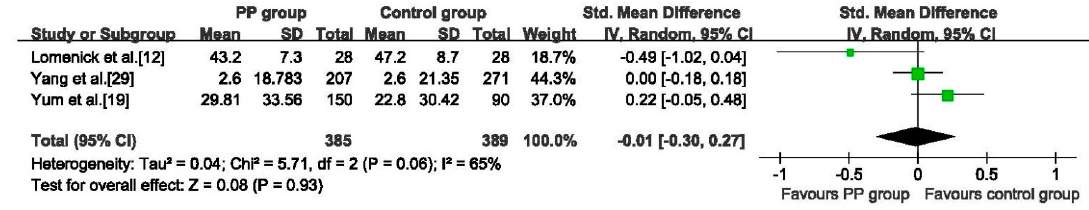
Figure 7. Forest plot for serum concentration of MBP between PP group and Control group.